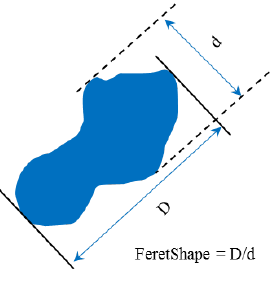
Figure 9. Illustration of the FeretShape parameter.